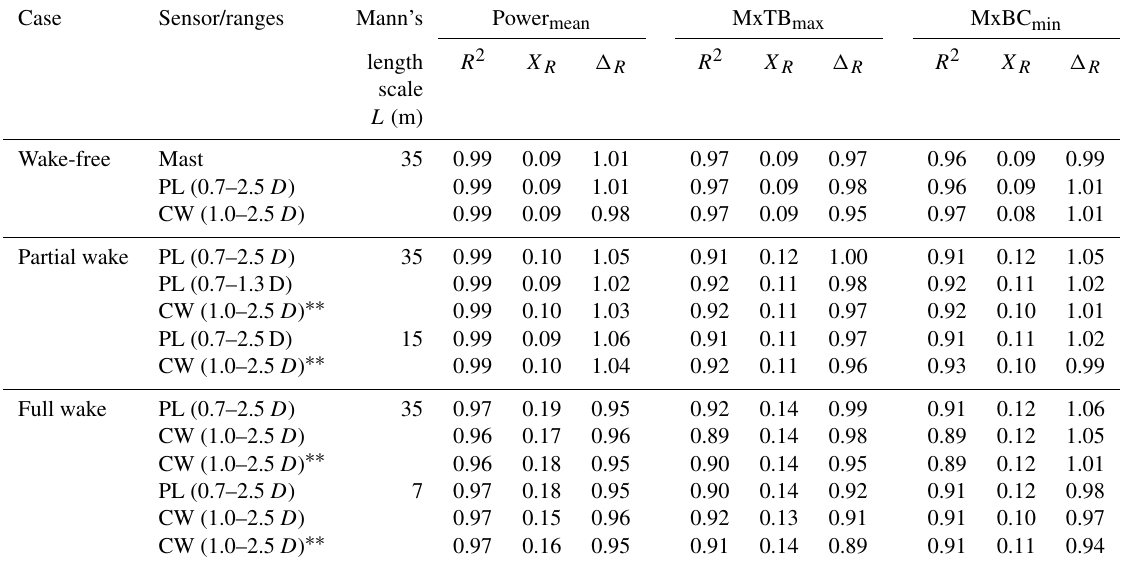
Table 2. List of accuracy and uncertainty values for power and extreme load validation procedures. The marker ∗∗ indicates unfiltered turbulence obtained from the ensemble-average Doppler spectrum of the radial velocity at 1.3 D .